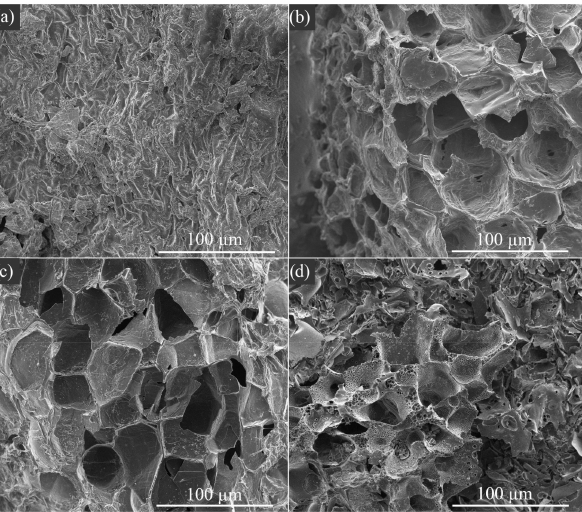
Figure 6. SEMimagesofthespentcoffeegrounds(SCG)( a )raw,( b )SCG_400,( c )SCG_500,( d )after activation.